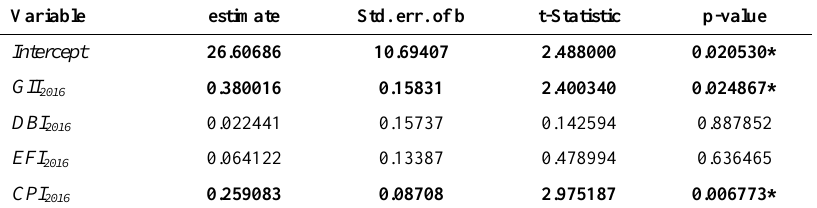
Table 5. The statistical output of the estimated variables for GCI score in 2016